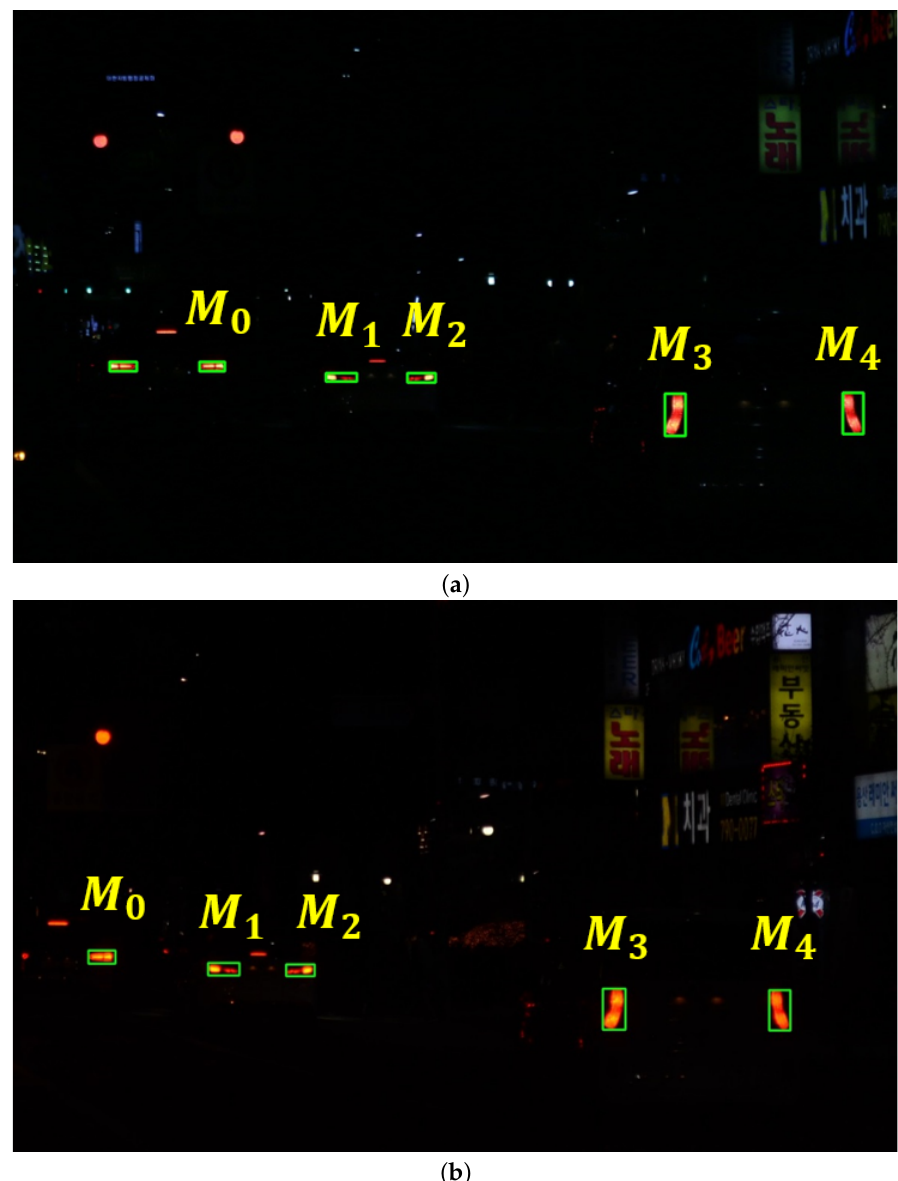
Figure 12. Taillight correspondence on the two images (the corresponding taillights are marked by the same label): ( a ) left image; ( b ) right